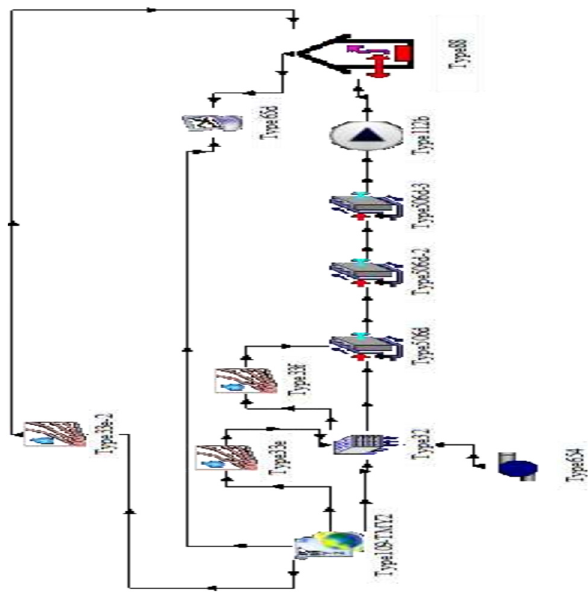
Figure 1: TRANSYS screen capture of the present system.